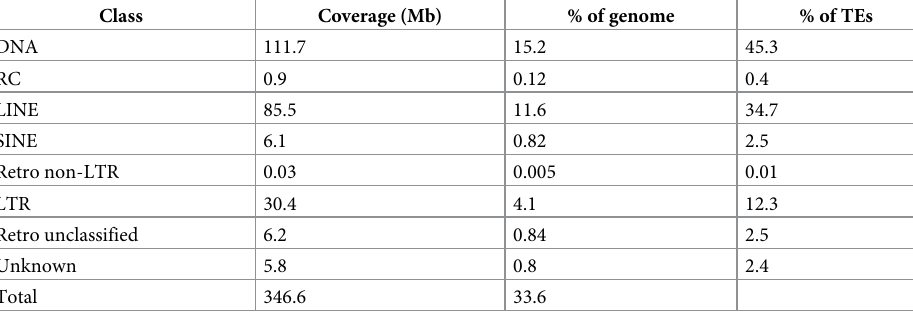
Table 2. TE coverage in the genome of O . latipes